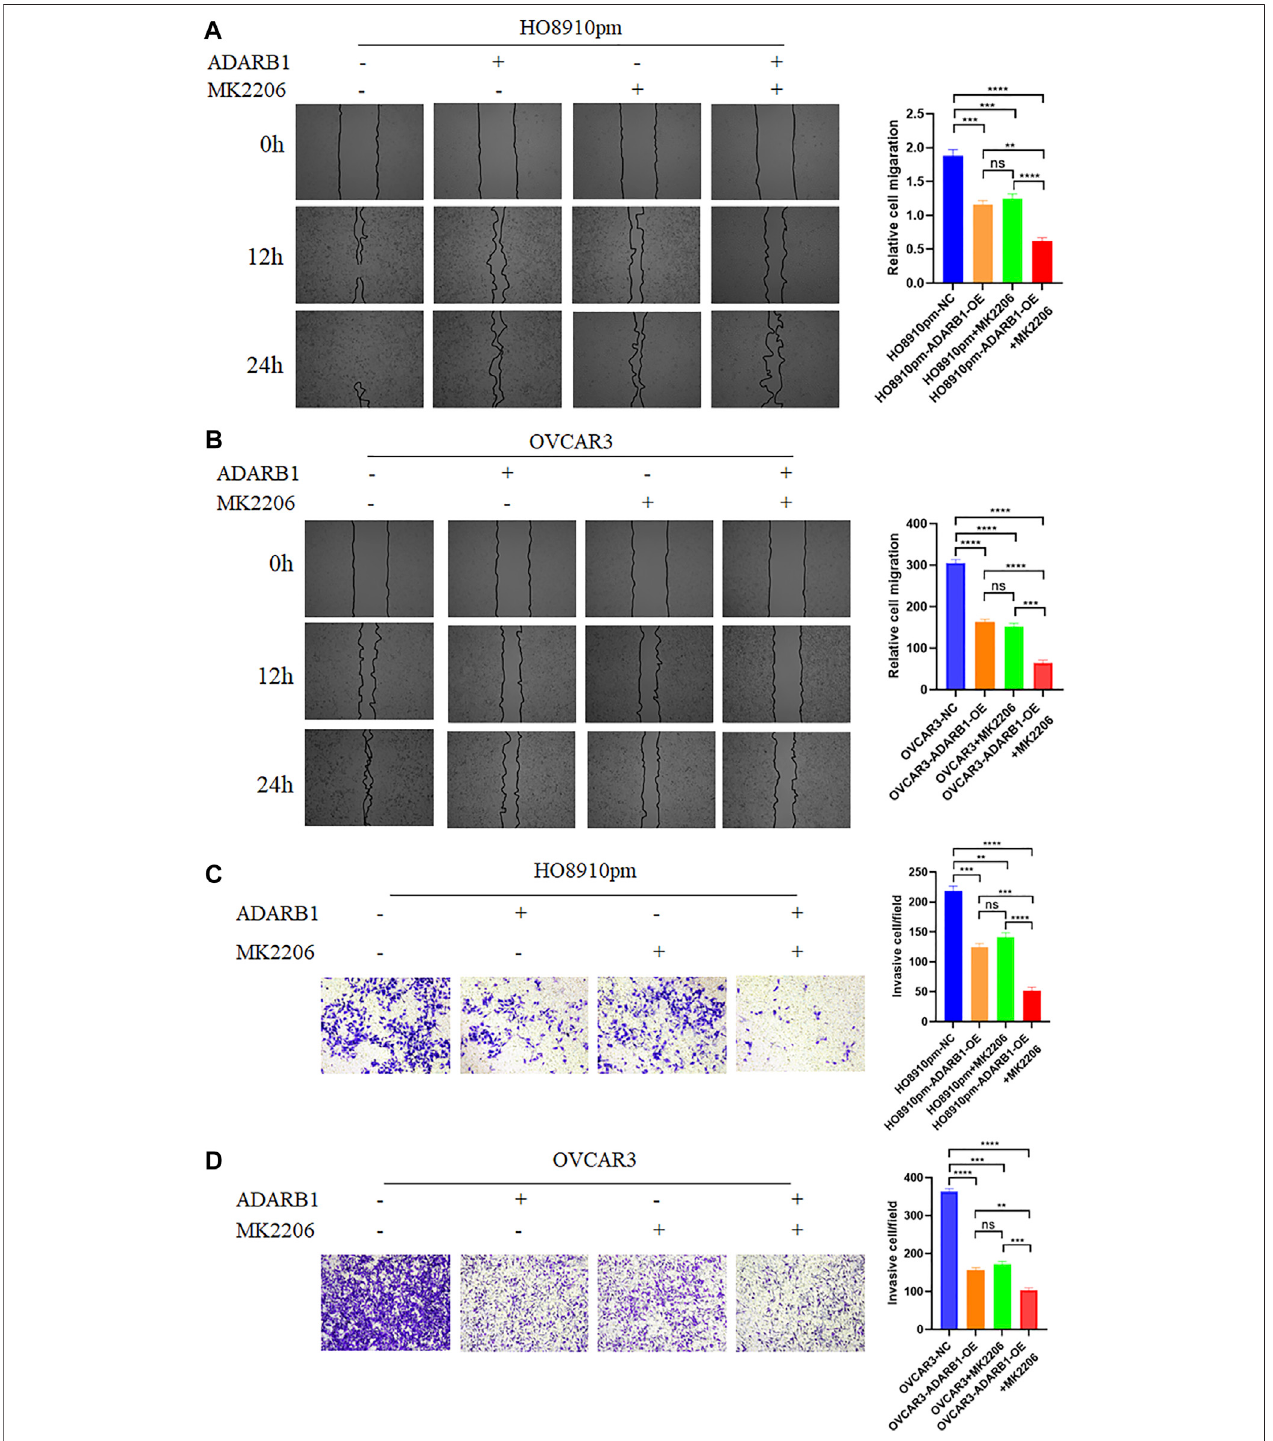
FIGURE 6 | ADARB1 inhibits OC cell Metastasis and invasion by regulating AKT pathway. (A,B) The wound healing assays were performed after HO8910pm and OVCAR3 cells treated with ADARB1-OE and/or AKT inhibitors MK2206. (C,D) The transwell assay were performed after HO8910pm and OVCAR3 cells treated with ADARB1-OE and/or AKT inhibitors MK2206.